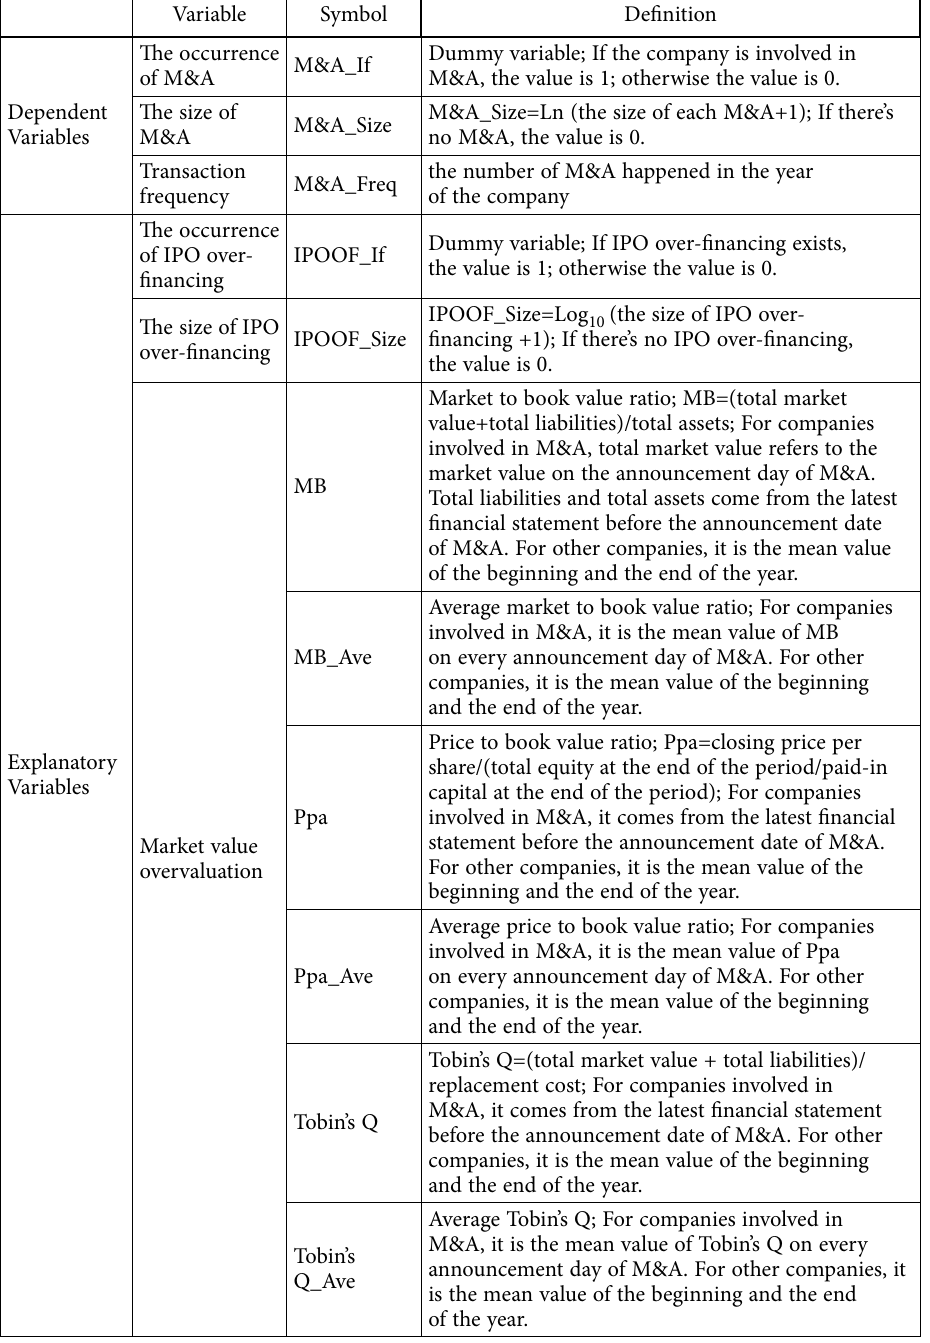
Table 4. Definitions of